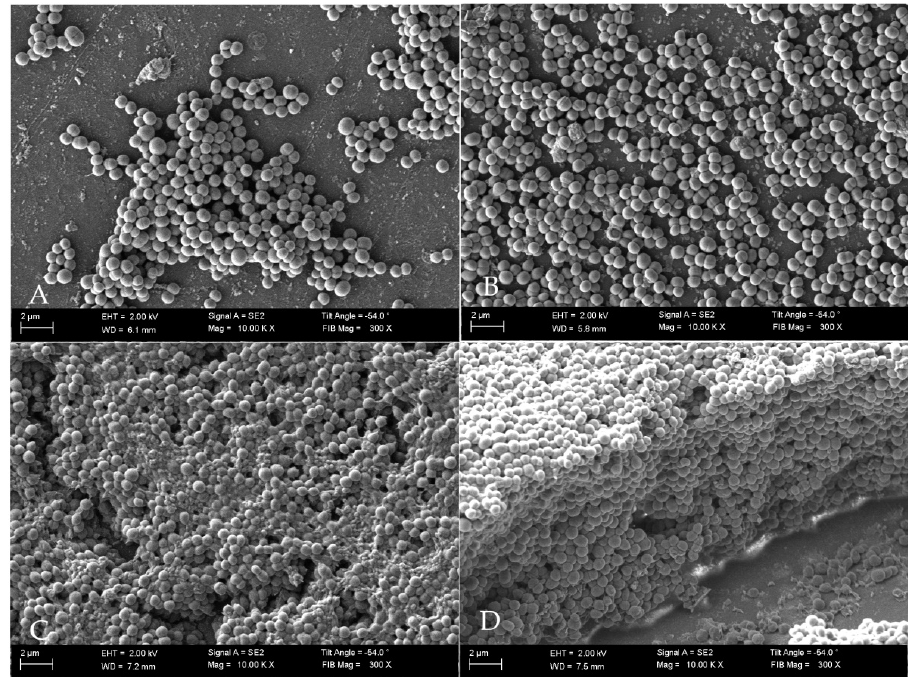
Figure 2. Images showing biofilm maturation process. ( A ) initial attachment phase, ( B ) cell aggre- gation and accumulation of biomass, ( C ) maturing biofilm; ( D ) mature biofilm. SEM Auriga 60